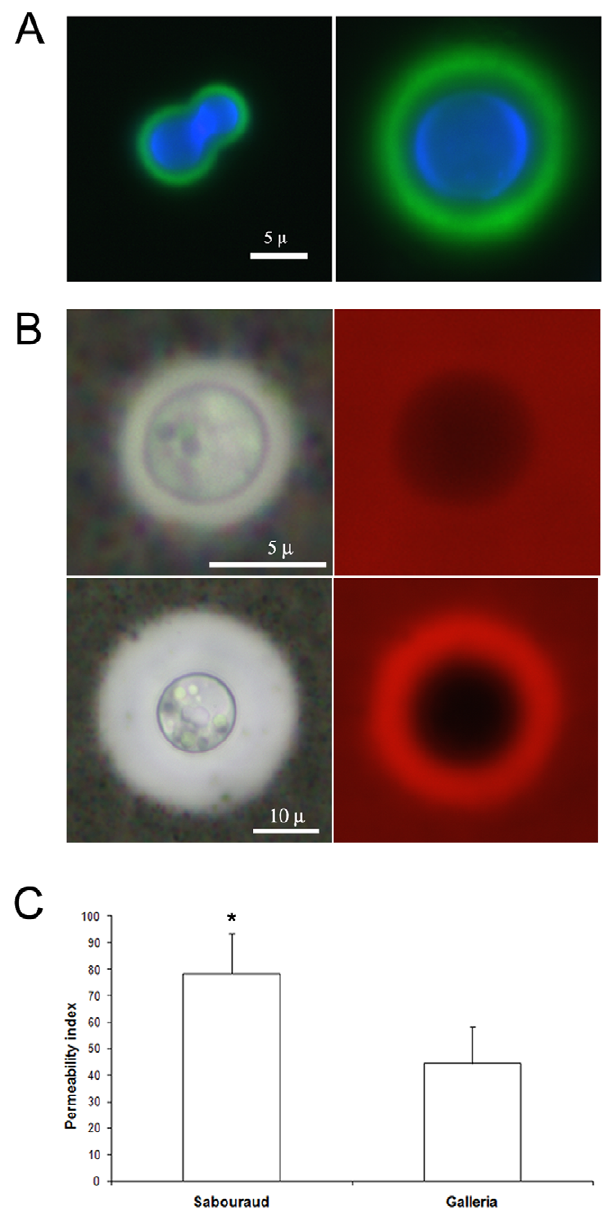
Figure 5. Capsular permeability of C.neoformans cells isolated from G.mellonella . A ) Immunofluorescence staining of the capsule with mAb18B7-Alexa 488 (green fluorescence) and of the cell body (blue fluorescence) of cryptococcal cells grown in Sabouraud broth and recovered from caterpillars infected with 10 4 cells per larva after 6 d. Scale bar in left panel applies to both. B ) Penetration of 70 KDa dextran Rhodamine labeled into the capsule and estimation of total capsule size by India ink staining. Upper panel shows cells grown in Sabouraud broth and lower panel cryptococcal cells recovered after 6 d from caterpillars infected with 10 4 cells per larva. Scale bar in left panel applies to both. C ) Distribution of permeability index calculated for cells grown in Sabouraud liquid medium (Sabouraud) and for cells recovered from infected larva (Galleria). T-test p value=0.0006.